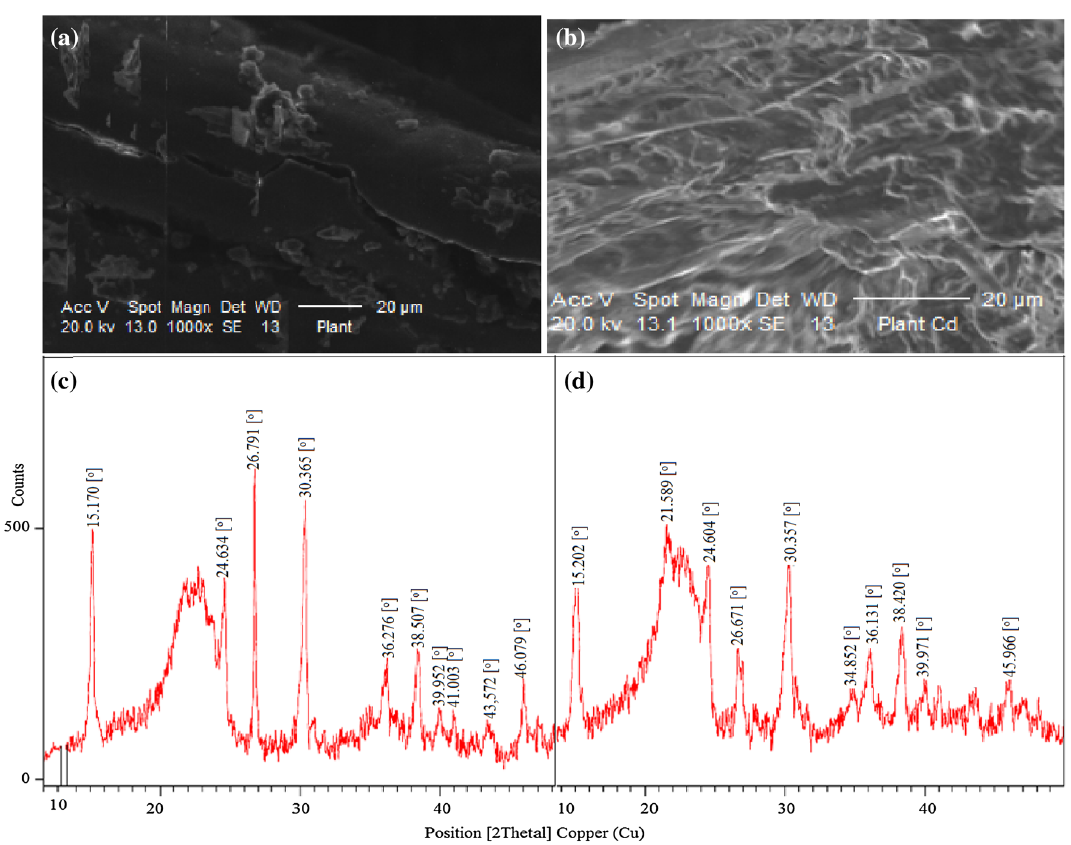
Fig. 5 SEM of A. heterophylla ( a ) before and ( b ) after Cd ? 2 loading. XRD pattern of the A. heterophylla ( c ) before and ( d ) after Cd ? 2